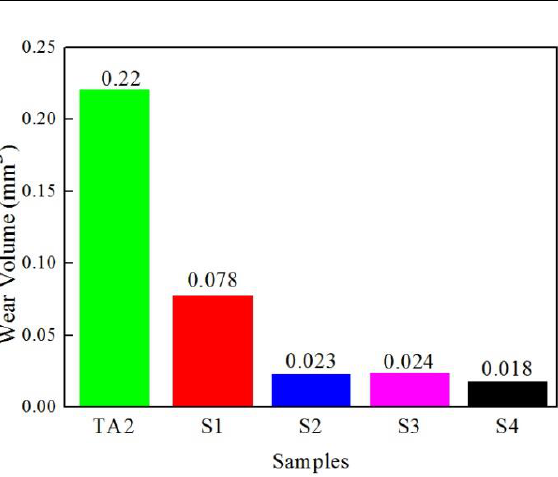
Figure 12. Wear volumes of samples S1 – S4 and TA2.